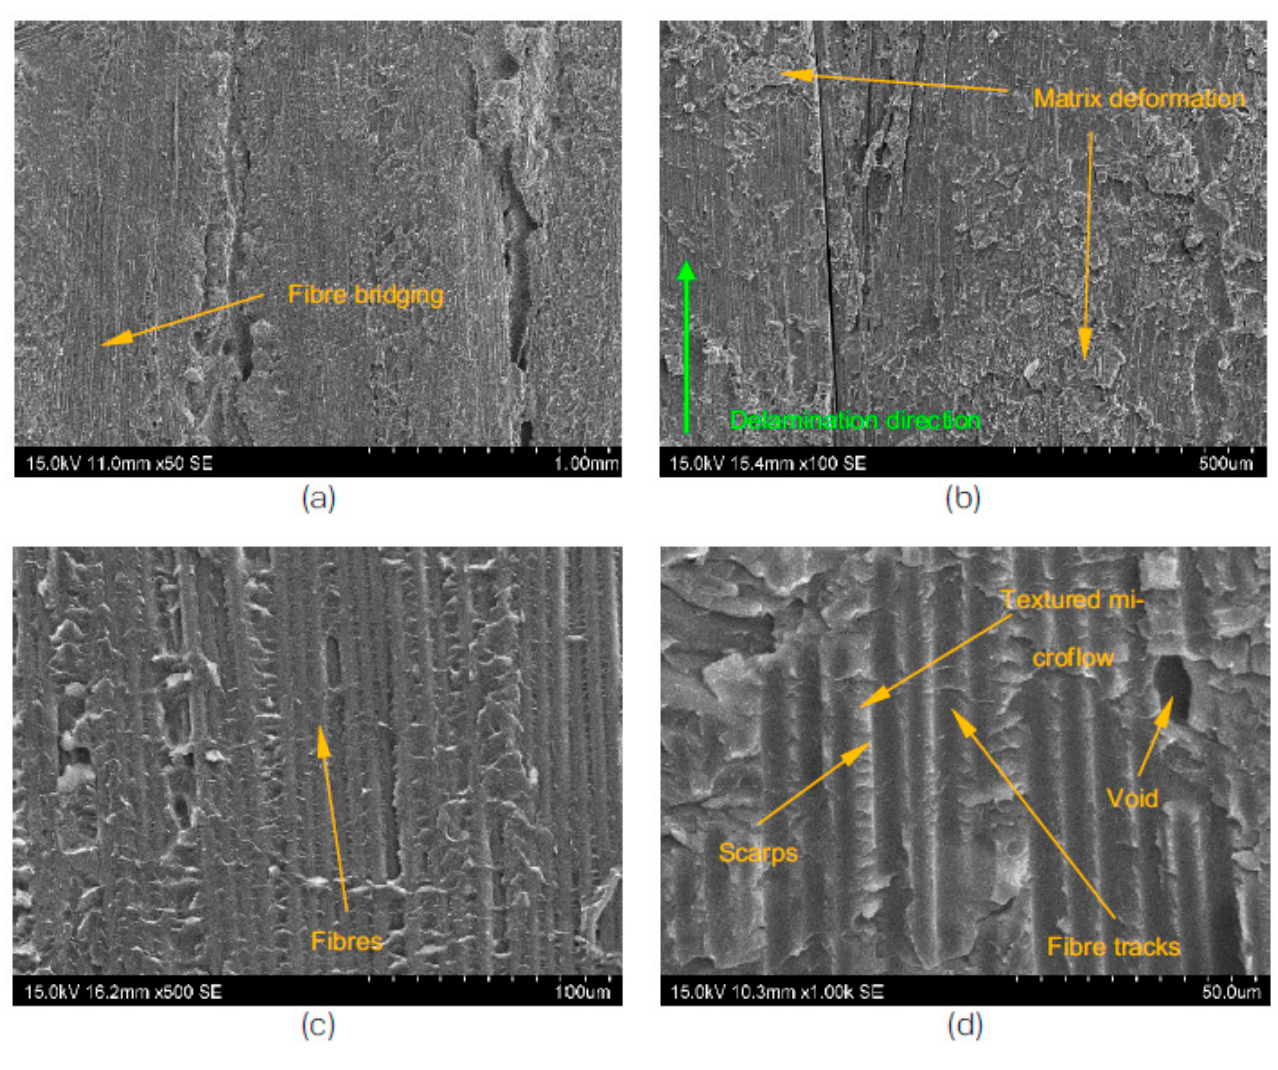
Figure 9. SEM view of the T700/PPS DCB specimens after the test; scale bar is ( a ) 1 mm, ( b ) 500 µm, ( c ) 100 µm, and ( d ) 50 µm.